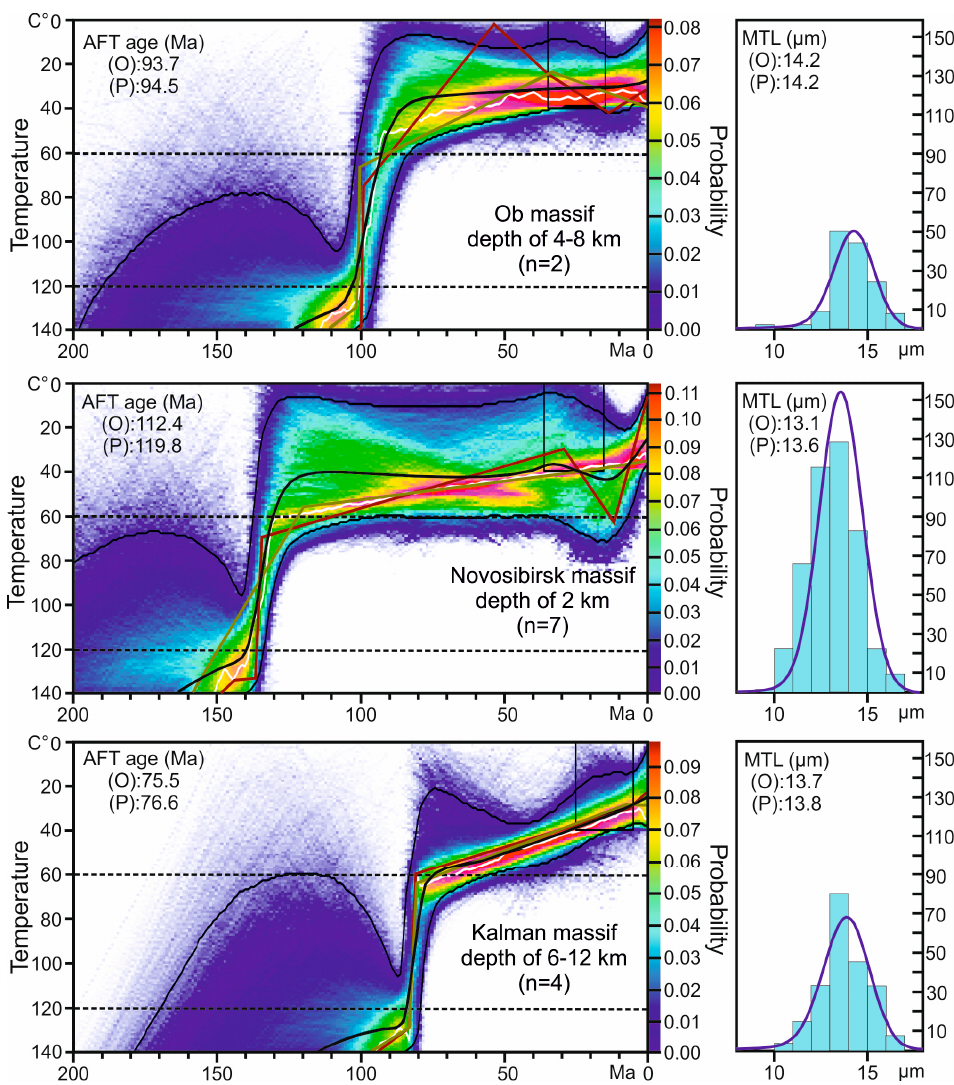
Figure 5. AFT thermal history model results for the Ob, Novosibirsk, and Kalman massifs produced by the QTQt software [44] combining n samples. Thermal history models are presented in a fixed time-temperature interval of 0 – 140 °C and 200 – 0 Ma. The color scale indicates high probability for red and yellow, and the blue colors indicate low probability values (see the caption of Figure 3 for further clarification).